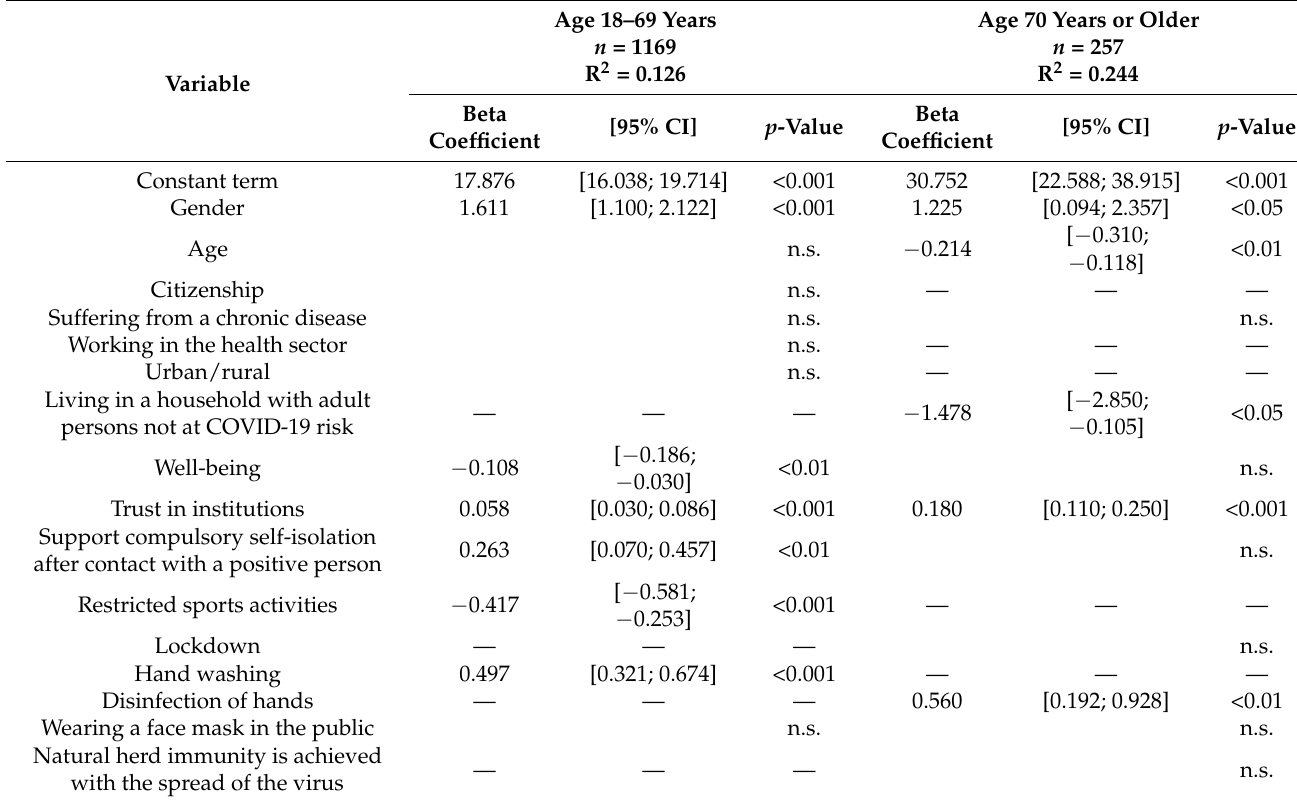
Table 2. Predictors of altruism in South Tyrol, Italy, in March 2021 in multivariate regression analyses for age groups 18–69 years and 70 years or older,